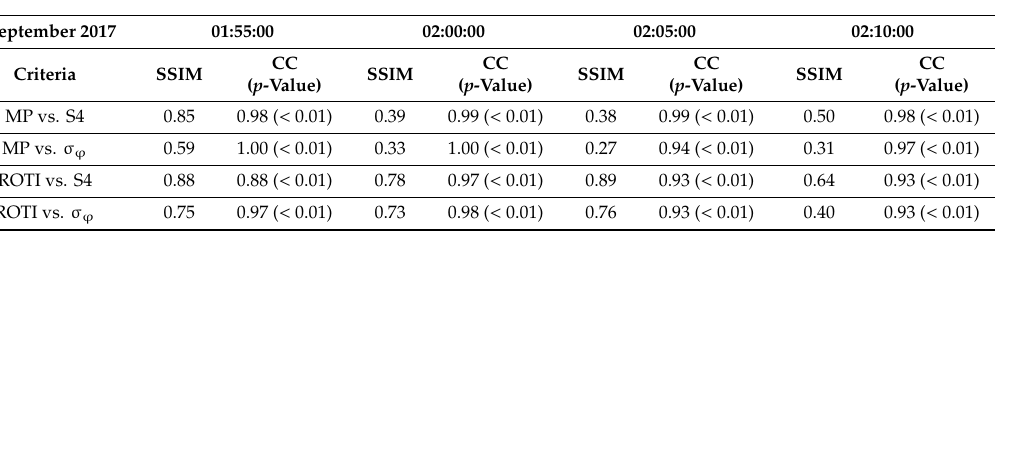
Figure 9. xxxxxxx Figure 9. Consecutive 5 min means over 20 min at SAO0P station on 8 September 2017. Table 10. SSIM and CC between the maps shown in Figure